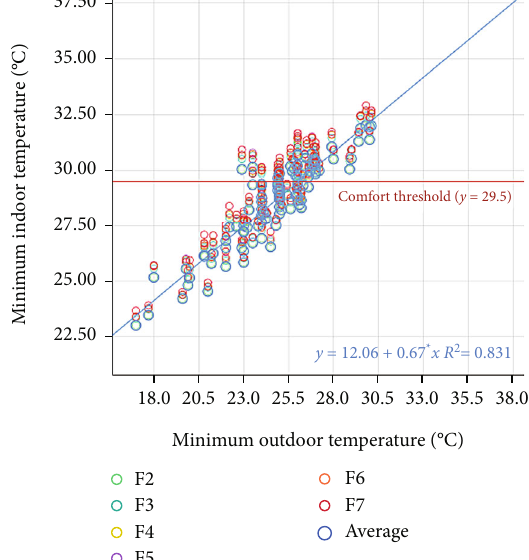
Figure 9: Daily minimum indoor temperatures in relation to minimum outdoor